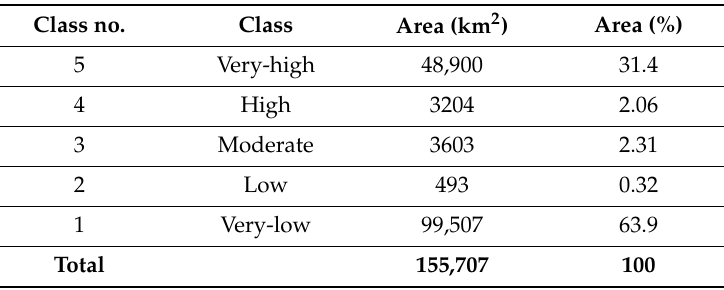
Table 4. Area under earthquake probability in Odisha.